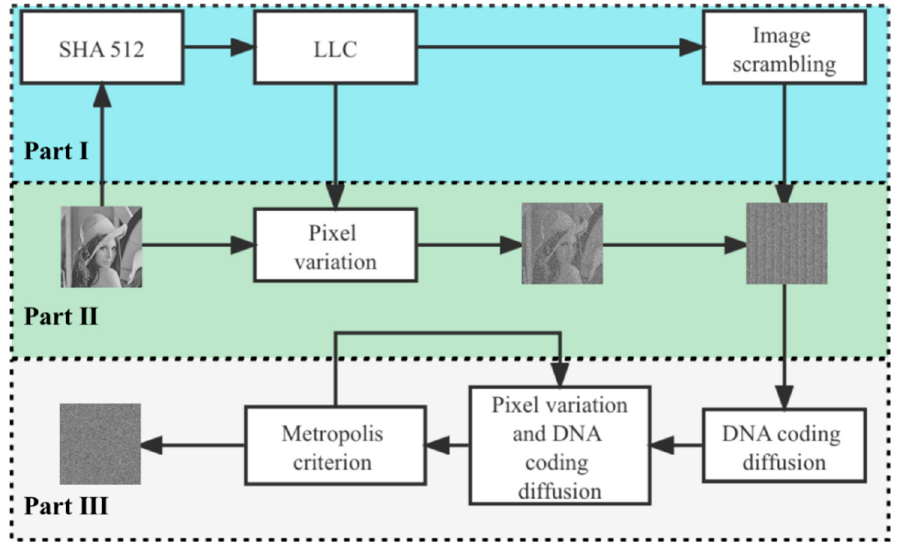
Figure 5. Encryption process flow chart.